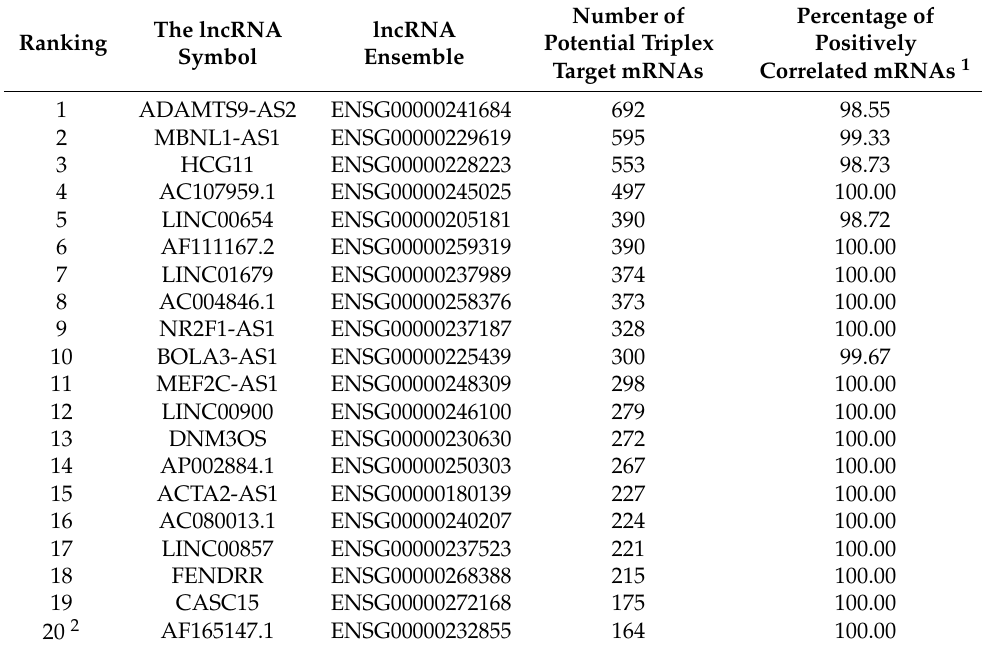
Table 3. The Top 20 lncRNAs with the maximum number of potential triplex target